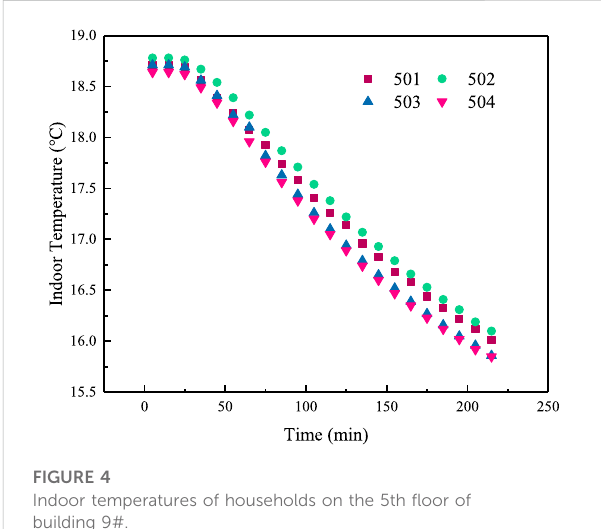
FIGURE 2 Effect of time on indoor temperature of households in building